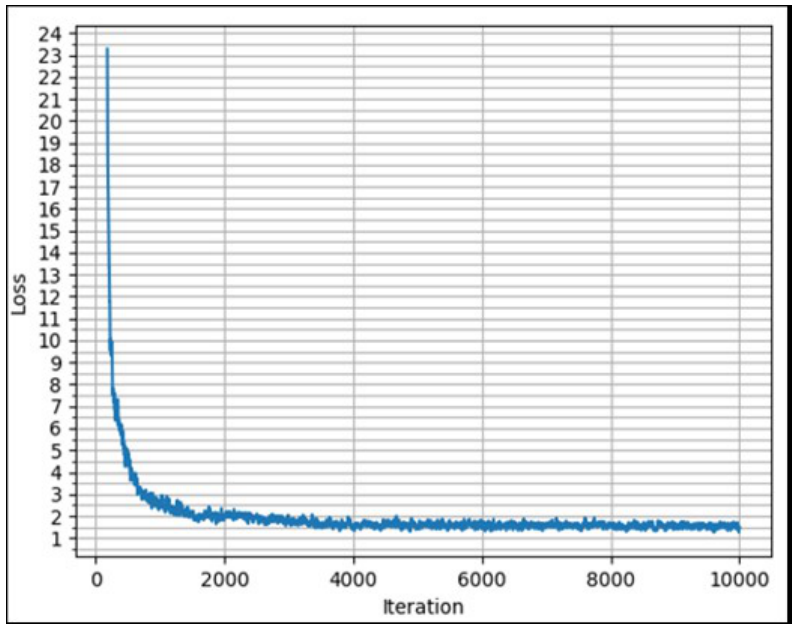
Figure 5. Loss curve of model